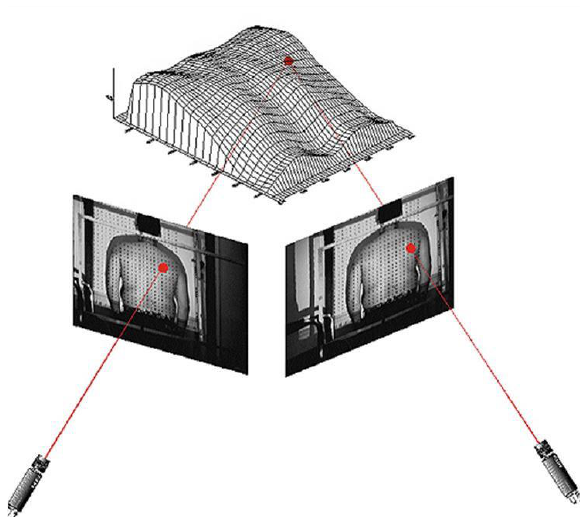
Figure 12. Image registration from the different sources; Source: (Patias et al.,